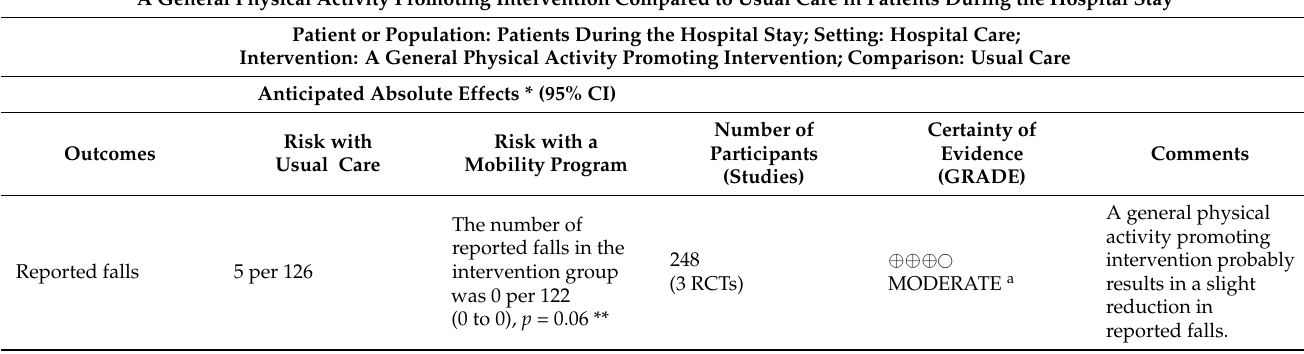
Table 3. Summary of findings according to Grading of Recommendations Assessment, Development, and Evaluation (GRADE) certainty of